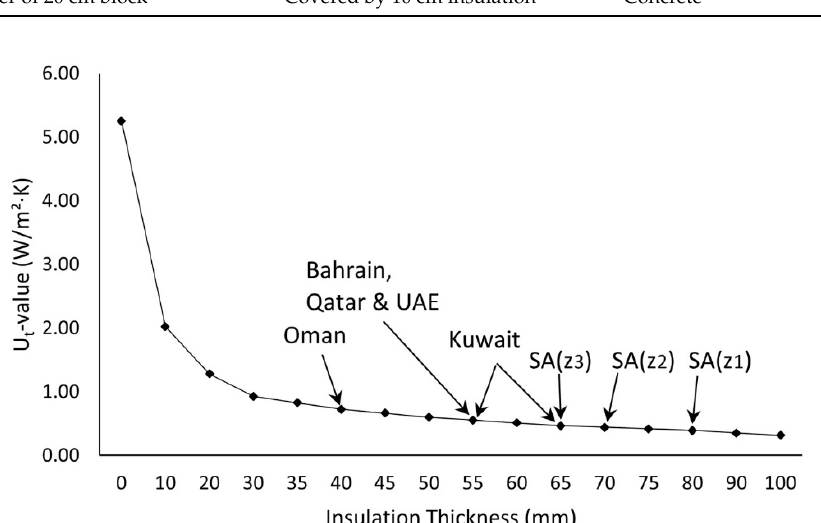
Figure 15. The benefit of using external insulation of varying thickness applied to a concrete frame structure with uninsulated concrete block in-fill and the thickness that meets the minimum U-value required for the Gulf countries (Adapted from Ref. [60–66].